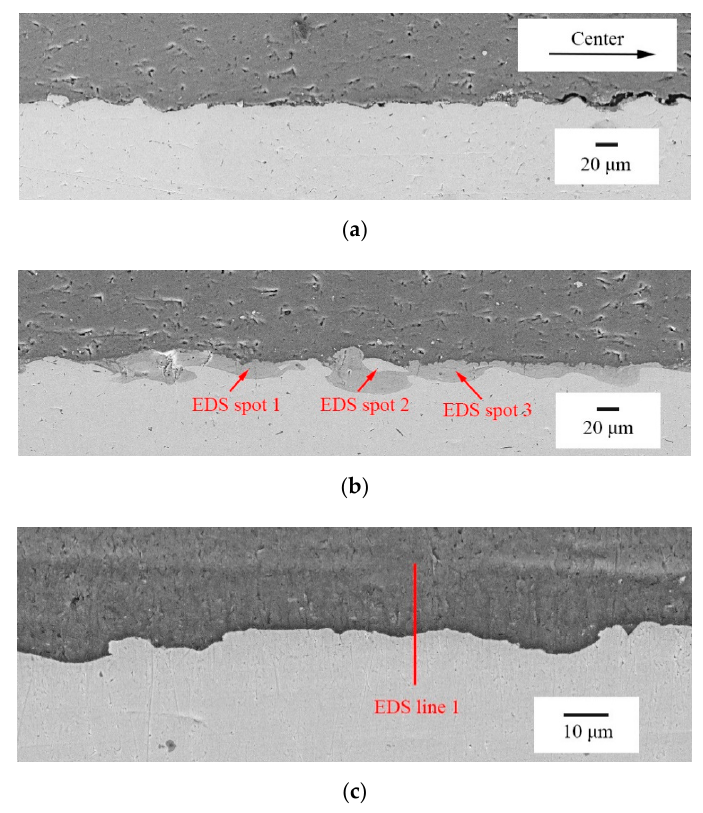
Figure 9. Interface morphologies of 3003 aluminium and 321 stainless steel at 8 kJ energy